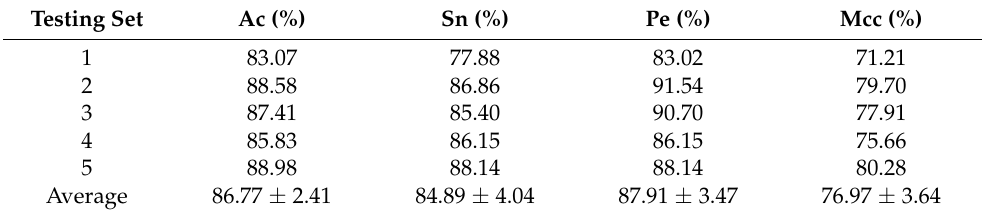
Table 3. 5-fold cross validation results performed by proposed model on a GPCR dataset. Testing